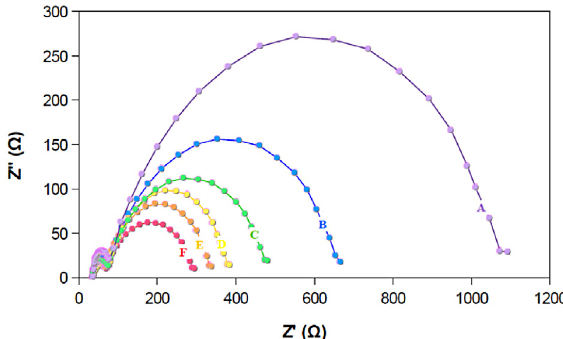
Fig. 8. Electrochemical impedance spectra (EIS) of the